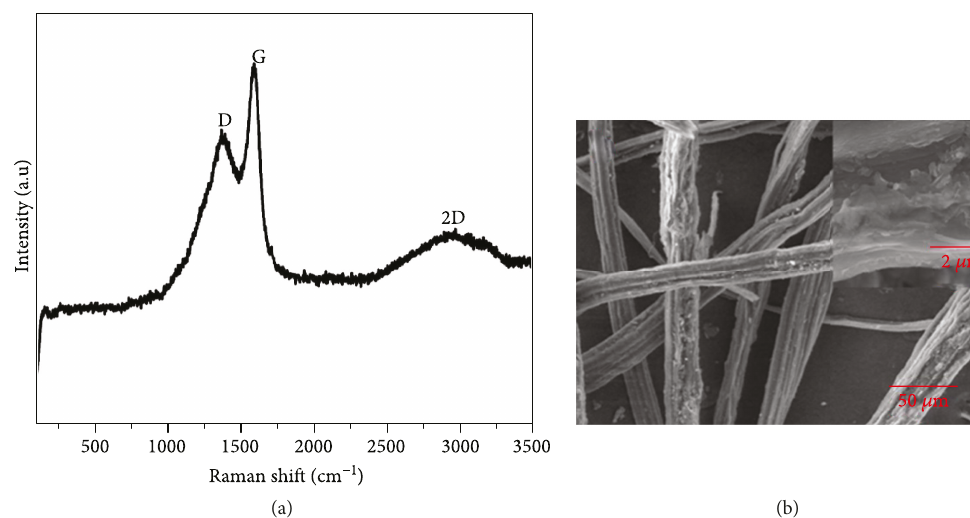
Figure 1: The Raman spectrum (a) and SEM image (b) of biomass carbon fi